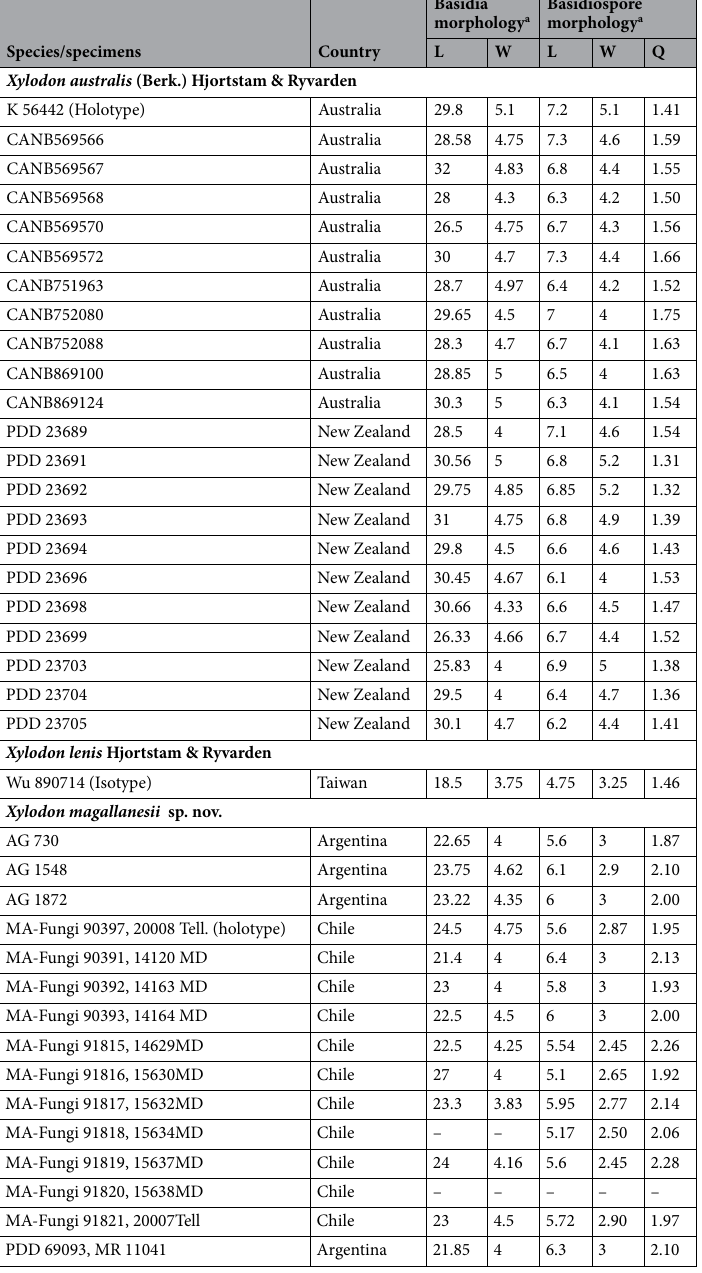
Table 1. Specimens included in the morphological analysis. L = length, W = width, Q = length/width ratios. a (–) = Not observed.